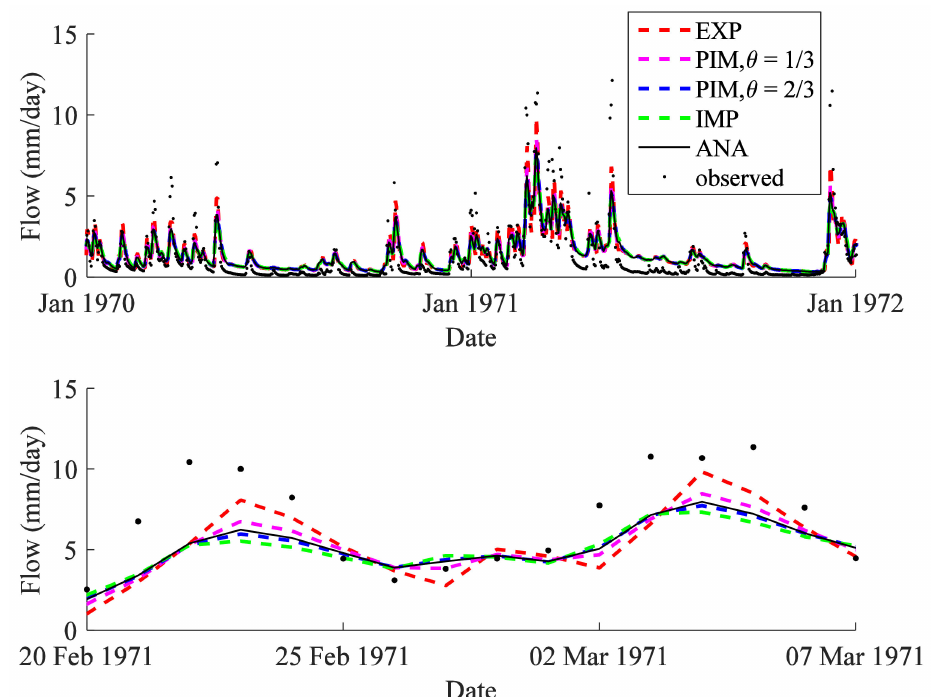
Figure 3. Flow hydrographs simulated with analytical solutions and the partially implicit Euler schemes for: January 1970–January 1972 ( top ) and 20 February 1971–7 March 1971 ( bottom